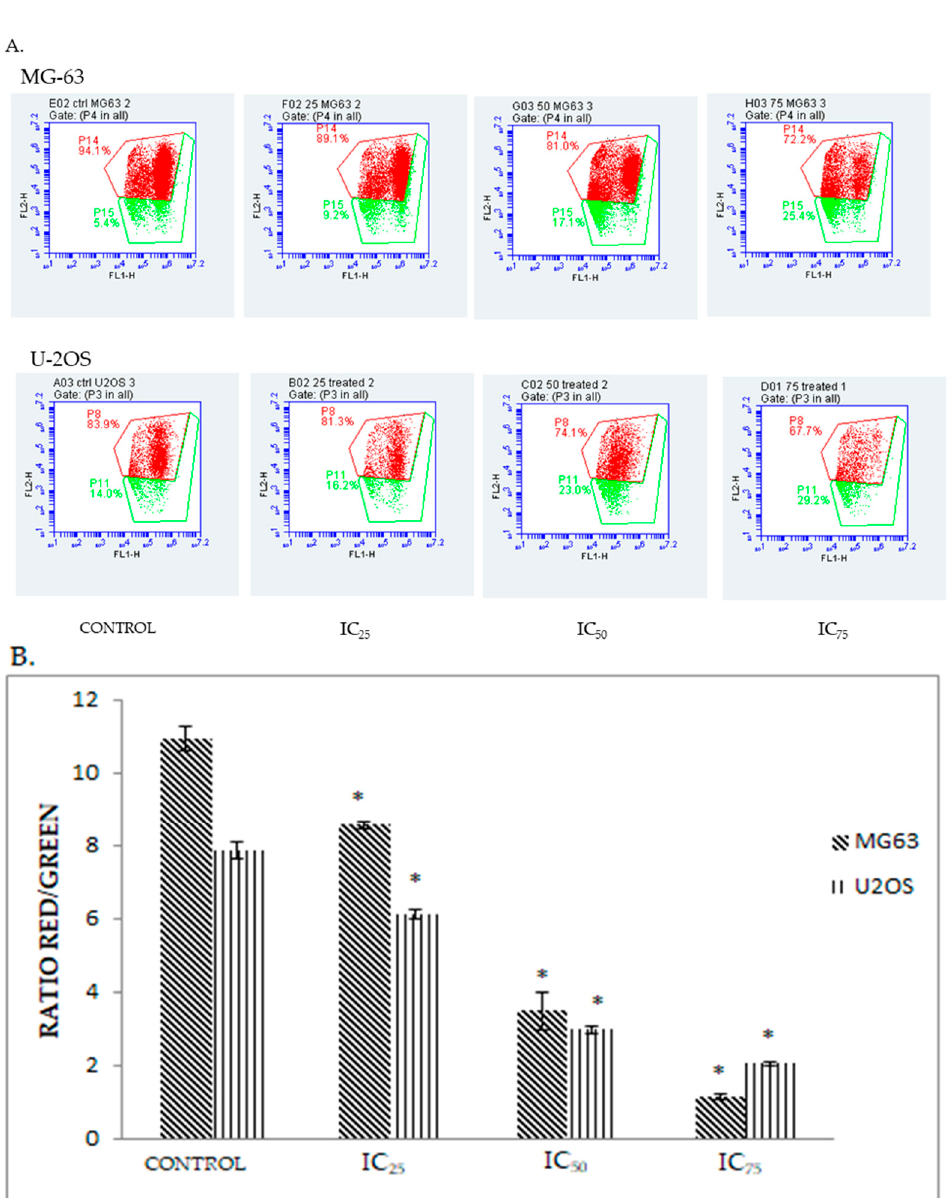
Figure 5. ( A ) Histogram analysis of the depolarization of mitochondrial membrane potential for MG-63 and U-2OS after being treated with three different concentrations of DK1 (IC 25 , IC 50 , IC 75 ) at 48 h; ( B ) Quantification analysis of mitochondrial membrane analysis for MG-63 and U-2OS when treated with three different concentrations of DK1. All data are expressed as mean ± standard error mean (S.E.M). * p < 0.05 compared with corresponding controls.